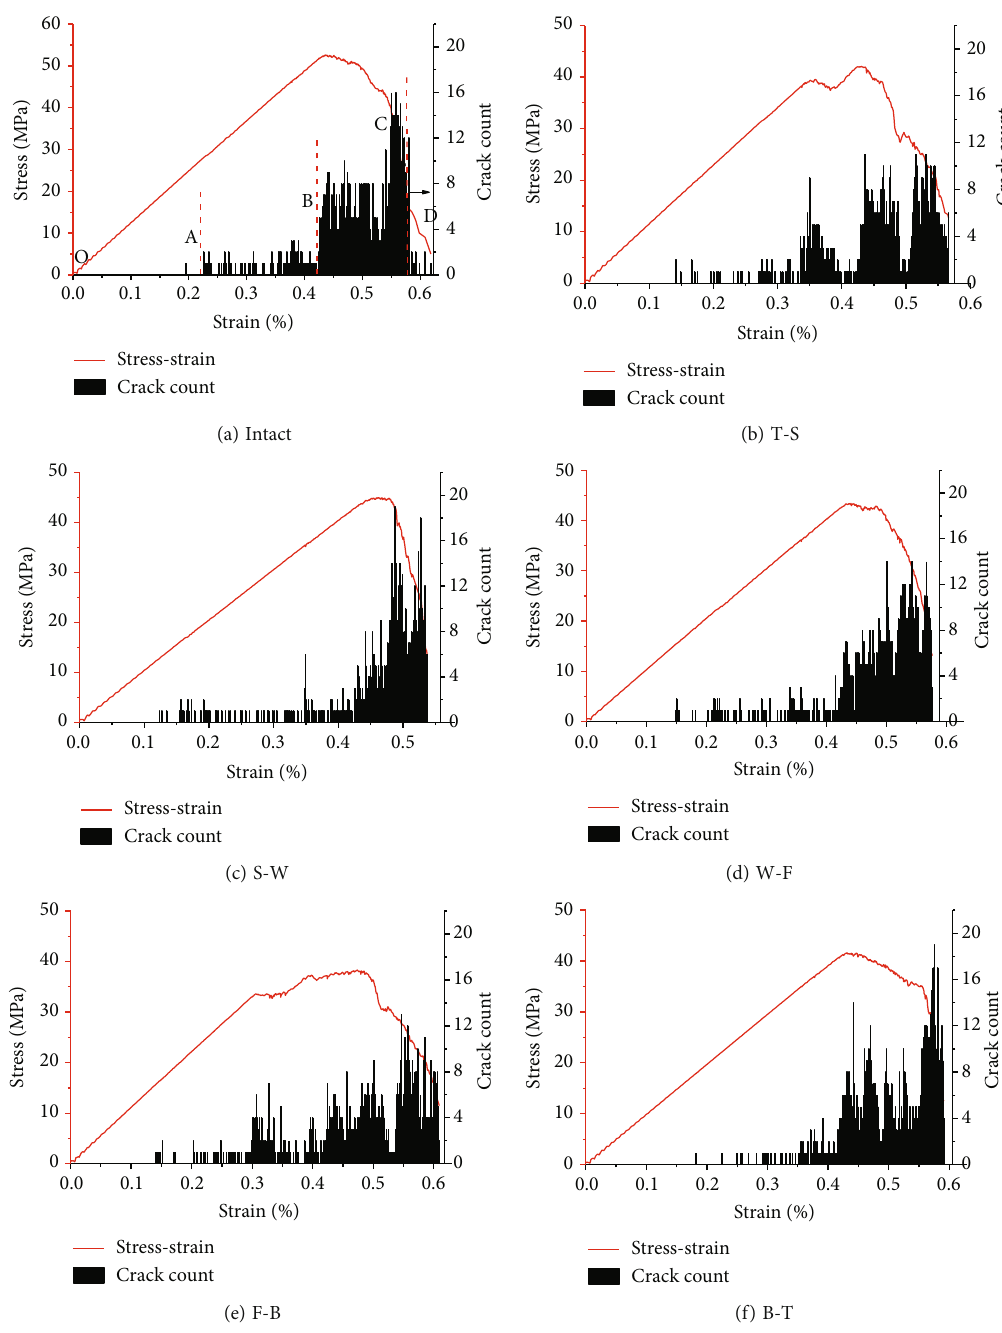
Figure 10: Stress-crack count curve of models with double-joint